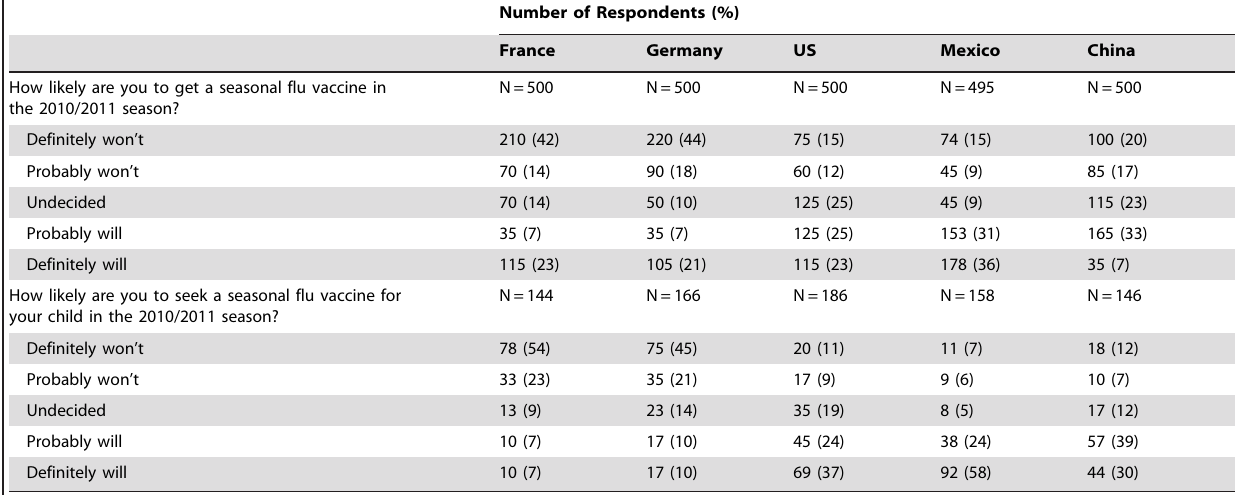
Table 3. General public opinions about seasonal